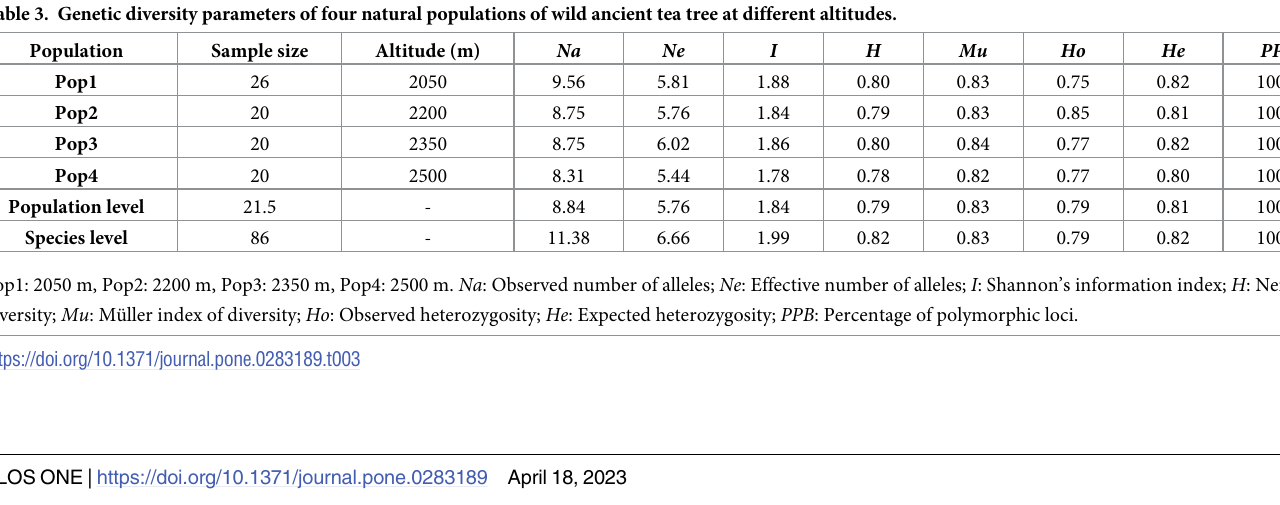
the values of Shannon’s index ( I ) varied from 1.78 to 1.88, with average of 1.84. Both H and I values indicated that genetic diversity of wild ancient tea tree at the population level was lower than that at the species level. In addition, as indicated by the Nei’s gene diversity and Shan- non’s information index, the variation trend of the genetic diversity of four wild ancient tea tree natural populations at different altitudes was generally consistent.